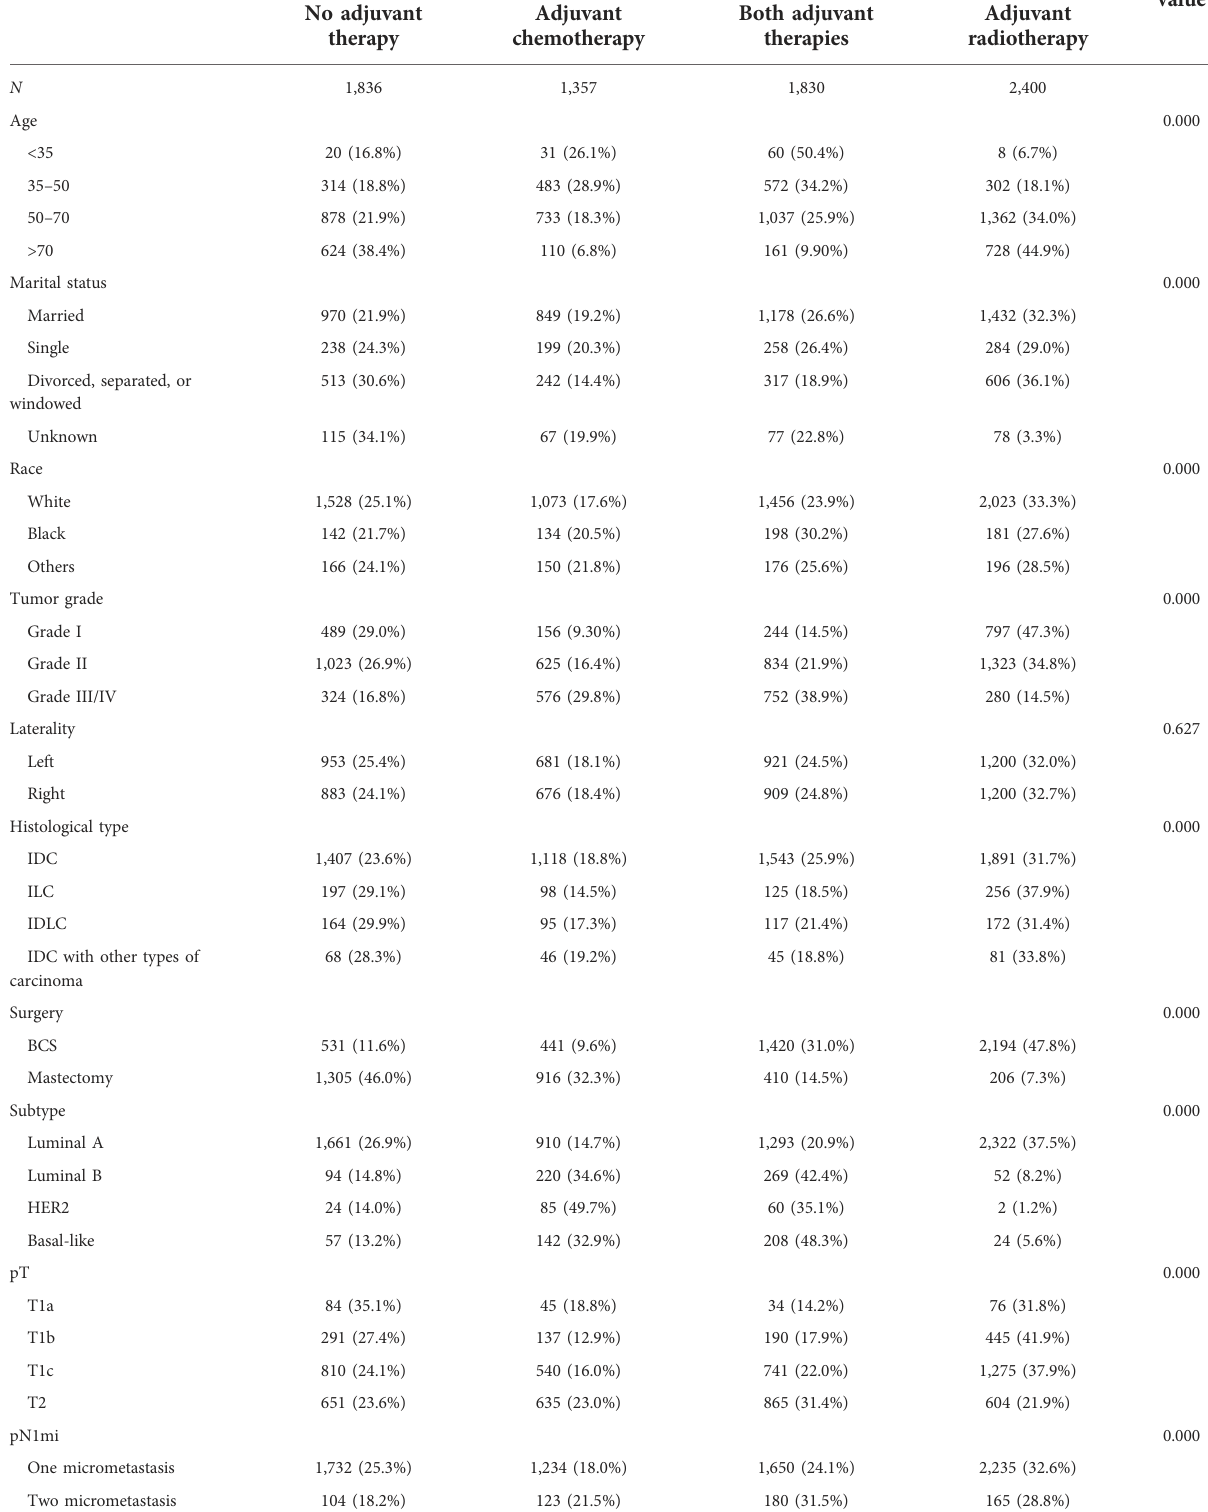
TABLE 1 Patient and tumor characteristics, strati fi ed by adjuvant treatments.